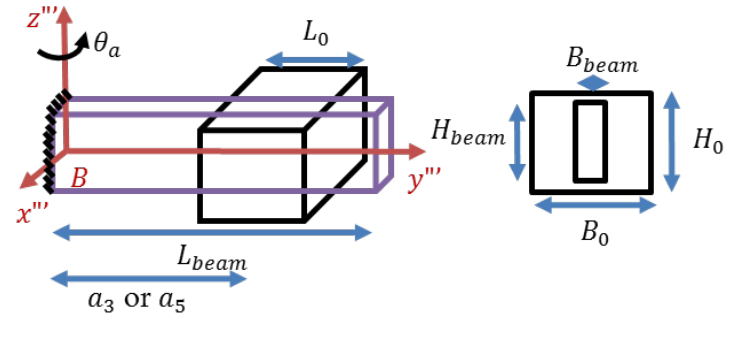
Figure 4. Designed dynamic vibration absorber. Table 2. Dimensions of the designed absorbers systems.